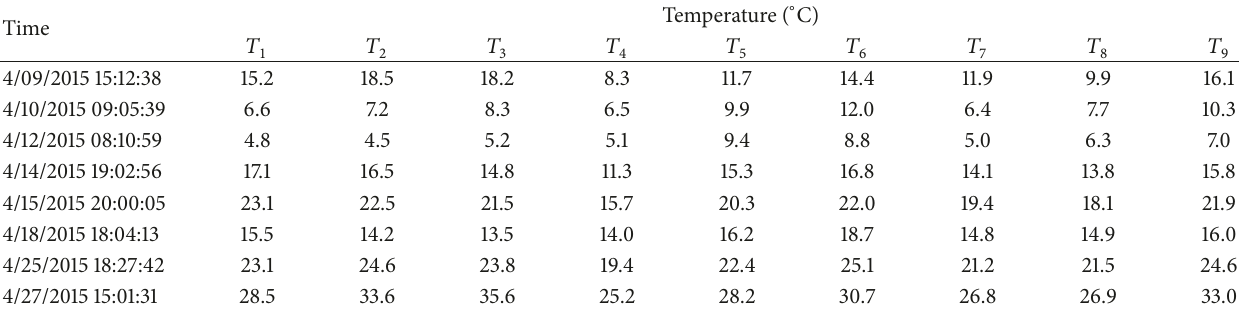
Table 3: The results from 𝑇 1 to 𝑇 9 at different